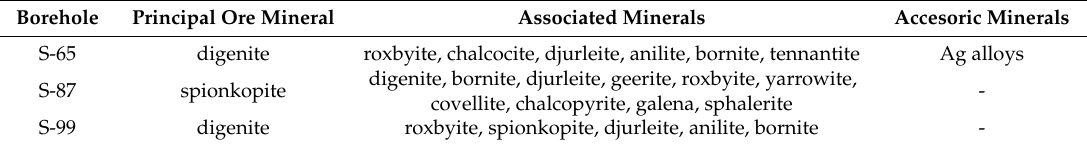
Figure 18. Photomicrographs of ore minerals from selected profiles of the Zechstein Cu-bearing series on the Fore-Sudetic Monocline in Poland (reflected light): ( A ) Bornite (Bn) replacing pyrite (Py) and carbonate minerals, Zechstein Limestone, S-303 borehole; ( B ) mineral aggregate composed of chalcopyrite (Ccp), bornite (Bn), sphalerite (Sp), galena (Gn), and digenite (Dg), Zechstein Limestone, S-209 borehole; ( C ) multi-mineral aggregate composed of chalcopyrite (Ccp), bornite (Bn), covellite (Cv), and sphalerite (Sp).,Weissliegend, S-262 borehole; ( D ) Rich copper mineralization represented by bornite (Bn), covellite (Cv), and digenite (Dg) co-existing with pyrite (Py), Kupferschiefer, S-117 borehole; ( E ) detrital grains cemented by digenite (Dg) with bornite (Bn) inclusions, Weissliegend, S-196 borehole; ( F ) carbonate minerals partially replaced by chalcocite (Cc) with tiny inclusions of bornite (Bn) and silver alloys (Ag-Hg), Kupferschiefer, S-99 borehole; ( G ) digenite (Dg) replacing fragments of foram and chalcocite (Cc) inclusions accompanied by hematite pigment (Hem), Zechstein Limestone, S-389 borehole; and ( H ) intergrowths of electrum (El) with digenite (Dg) and covellite (Cv) associated by hematite (Hem), Zechstein Limestone, S-391 borehole. Table 8. Ore minerals identified in selected samples by using an electron microprobe (EPMA).